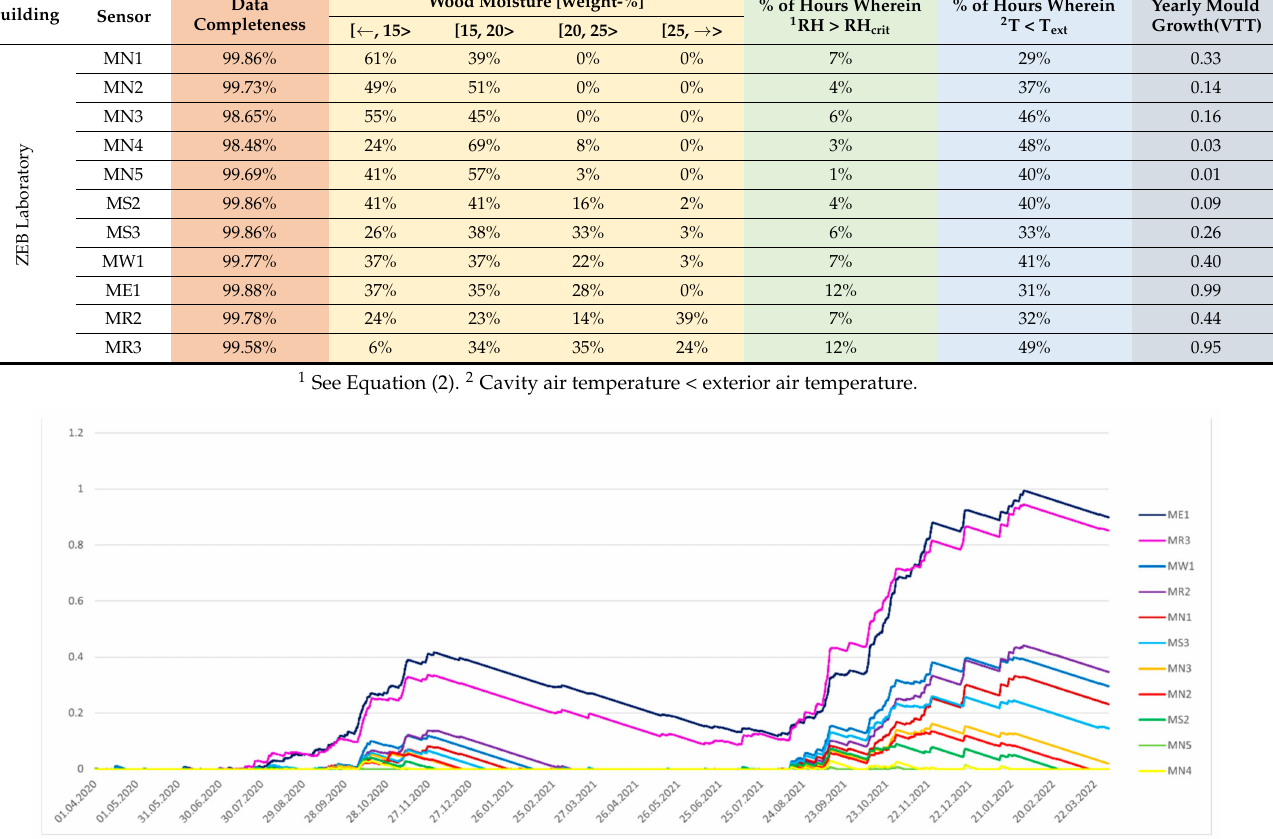
Figure 12. Development of the VTT Mould Growth Index for the ZEB Laboratory. The wood moisture measurements show three clear outliers: Sensors SW-1, MR2, and MR3 all have significantly higher periods of wood moisture content > 25% than the other sensors. However, sensors MR2 and MR3 display much lower levels of air humidity (as seen in Table 5), and on-site inspection suggests that the high moisture levels are caused by rain intrusion. Conversely, SW-1 displays consistently higher RH levels, which indicates a much higher mould growth potential as seen in the VTT analysis. The outlier sensors in the ZEB Laboratory score < 1 in the mould growth index, while SW-1 achieves an index value close to 5. It is worth noticing that the wood moisture measurements and the VTT mould growth index do not correlate substantially, as illustrated by for instance sensors SW-2 and MS2. While the two display quite similar values of wood moisture content distribution, MS2 has a mould growth index score of 0.09 while SW-2 reaches